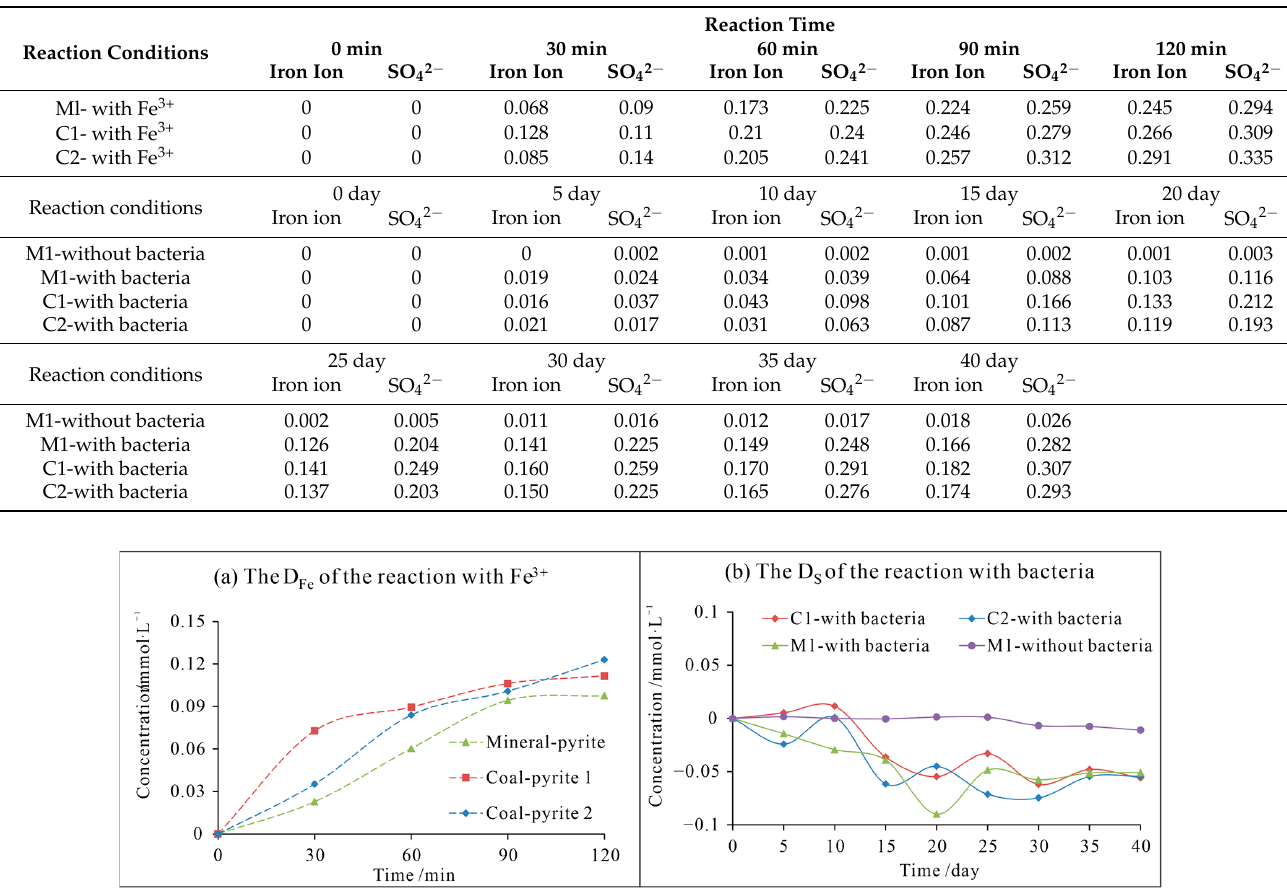
Table 5. The concentration increase of iron ion and SO 42 − caused by pyrite oxidation, mmol/L.